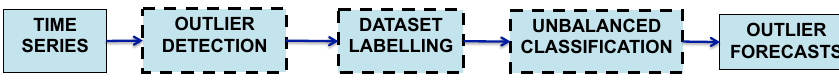
Figure 1. Illustration of the proposed